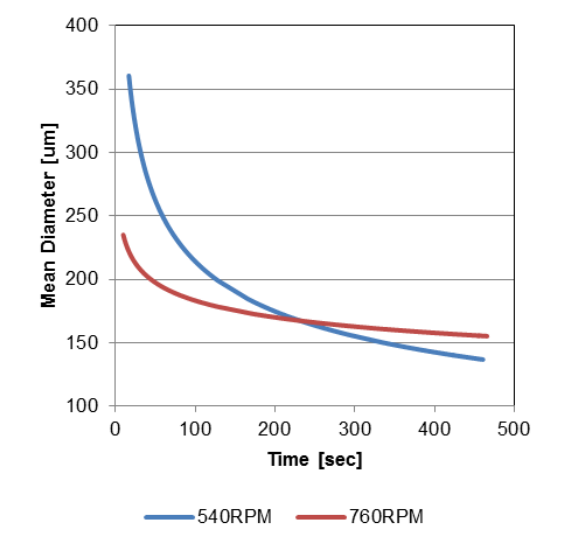
Fig. 4. Interpolated curves for Mean Particle Diameter time dependence of Rhodosil Oil 47V50.